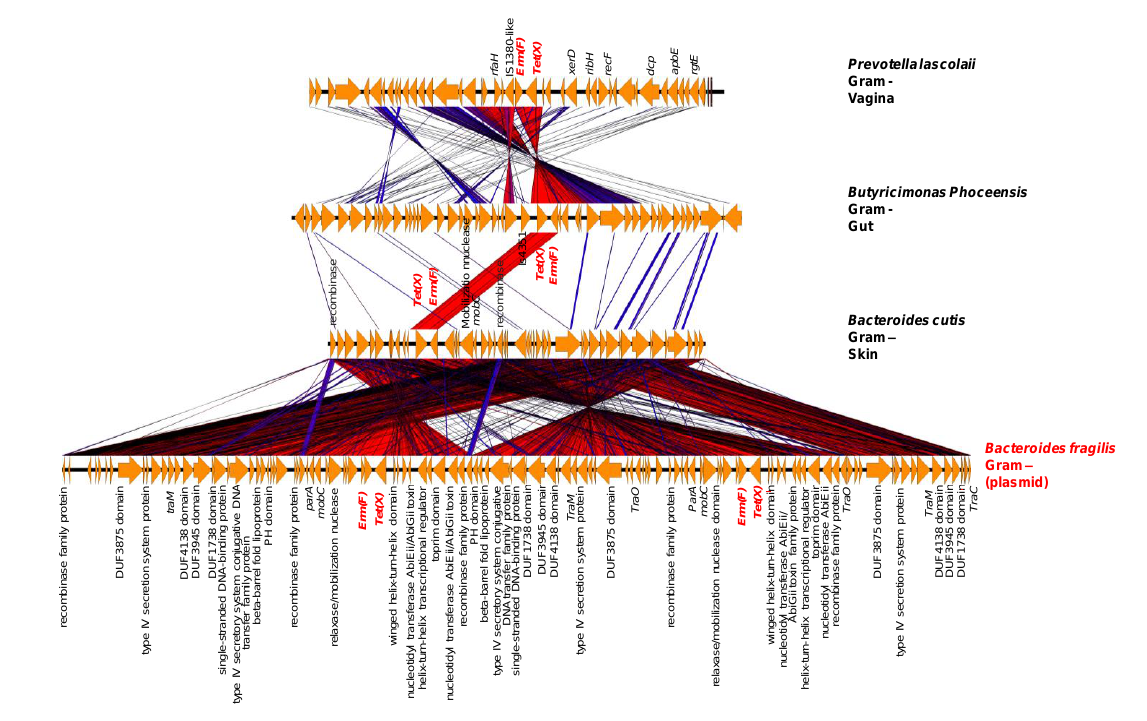
Figure 7. Comparison of the genetic environment from Bacteroides fragilis strain FDAARGOS (Acces- sion number: CP054002) plasmid containing erm(F) and tet(X) ARGs isolated from the transverse colon and three new species studied. The figure illustrates potential gene transfer between bacteria isolated from human microbiota. The color gradient from blue to red indicates the percentage of sequence similarity between the genes in the genetic environments studied.